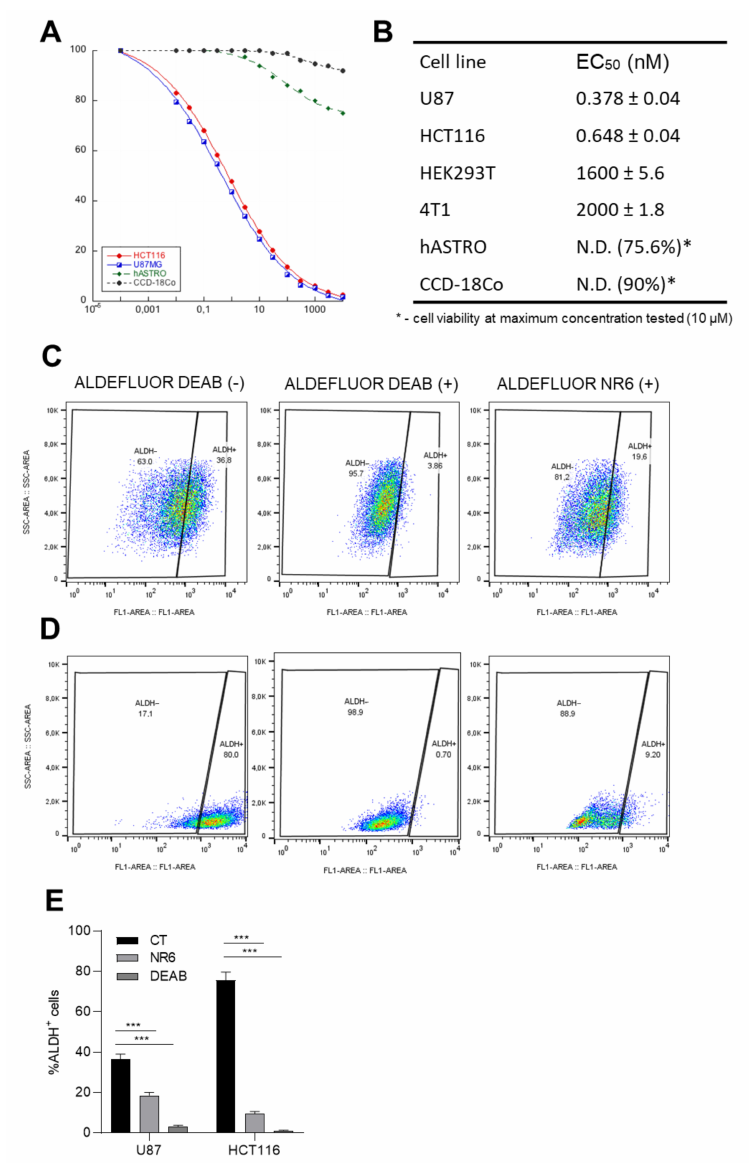
Figure 5. ALDH1A3 inhibitor NR6 determines cell death in ALDH1A3-overexpressing cells, reducing ALDEFLUOR positivity. ( A ) Dose-response curves of U87MG, HCT116, hASTRO and CCD-18C O cell lines treated with NR6 for 72 h. ( B ) EC 50 table values. EC 50 s were calculated with concentration– response curves and using Kaleidagraph software. Shown are mean percentages ± SD of three independent experiments ( n = 12 for viability). ( C , D ) ALDEFLUOR assay in U87MG and HCT116 respectively, treated with ALDEFLUOR probe only (on the left), 10 µ M DEAB as positive control (in the center) and with 1 µ M NR6 (on the right). ( E ) Percentage of ALDH positive cells evaluated with flow cytometer, 2 replicates of n = 4 independent experiments. (*** p < 0.001 by unpaired two-tailed ANOVA